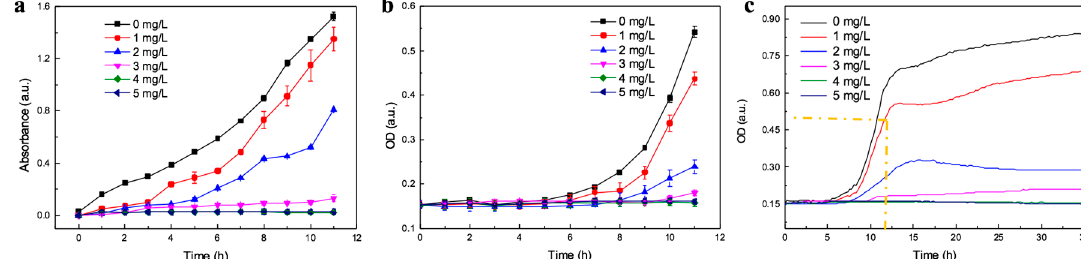
Figure 6. Inhibition test of E. coli by amoxicillin: ( a ) The growth curve of bacteria on chip exposed to di ff erent concentrations of amoxicillin for 11 h. ( b ) Bacterial growth in 96-well plate exposed to di ff erent concentrations of amoxicillin for first 11 h. ( c ) Bacterial growth in 96-well plate for 35 h. Bacterial growth for first 11 h is marked by yellow dash line.